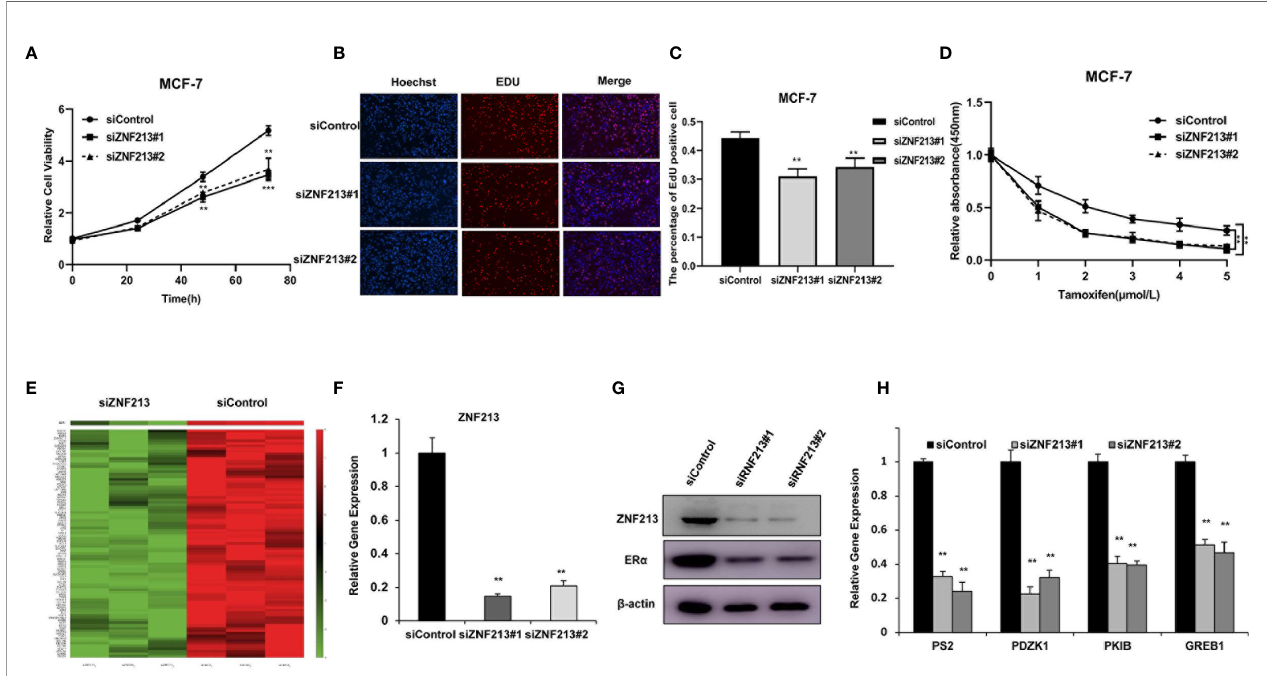
FIGURE 2 | ZNF213 is required for cell proliferation and ER alpha signaling in breast cancer cells (A) Depletion of ZNF213 inhibits the proliferation in MCF-7. Cells were transfected with siControl or siZNF213. After 24 h, the assay was CCK8 used to determine the cellar metabolic activity at indicated time points after infection. Experiments were done in triplicates. **P < 0.01; ***P < 0.001 for cell growth comparison. (B, C) DNA synthesis assessed using EdU assay in MCF-7 transfected with siControl or siZNF213. Experiments were done in triplicates. **P < 0.01 for cell growth comparison. (D) Comparison of tamoxifen sensitivity between siControl and siZNF213. MCF-7 cells were transfected with siZNF213 or siControl. After 24 h, cells were plated into 96-well plate, while each well contained 4,000 cells. The indicated tamoxifen concentrations were used for 48 h. The numbers of the cells were determined via CCK8 kit for the cellar metabolic activity. Experiments were done in triplicates. **P < 0.01; for cell growth. (E) The heat-map graph shows the ER alpha regulating genes, which is signi fi cantly inhibited by ZNF213 depletion in MCF-7 cells. The pathway-enrichment analysis was used by the threshold P < 0.001 and fold change >2 to derive regulated genes. ZNF213 was depleted by siRNA (mix of siZNF213 #1 and siZNF213 #2) or treated with siControl. After 48 h, the whole mRNA was extracted for RNA sequence analysis. The siControl and siZNF213 were done in triplicates. (F) ZNF213 depletion effect by two different siRNA oligos. MCF-7cells were transfected with two independent ZNF213 siRNAs or siControl. The relative ZNF213 mRNA levels were determined by QPCR. (G) ZNF213 depletion effects on ER alpha protein level by two different siRNA oligos. MCF-7cells were transfected with two independent ZNF213 siRNAs or siControl. ZNF213 and ER alpha protein levels were determined by Western blot analysis. Actin was used as internal control. (H) ZNF213 depletion decreases ER alpha target genes. MCF-7 cells were transfected with siZNF213 or siControl. After 48 h, total RNA was prepared and the expression of the endogenous ER alpha target genes, PS2, GREB1, PKIB, and PDZK1 were determined by qPCR. Shown are the results from three experiments. **P < 0.01 for target gene expression